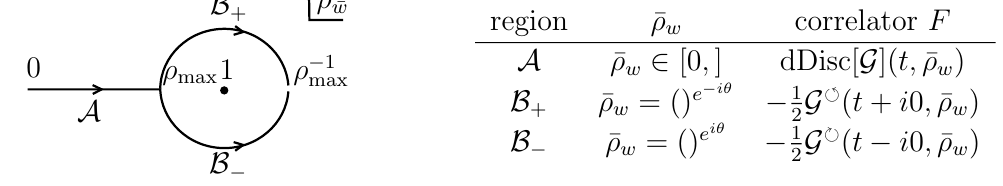
Figure 5 . Keyhole contour in the (cid:22) (cid:26) w variable to avoid cross-channel singularity (at (cid:22) w = 1). The angle runs over (cid:18) 2 [0 ; (cid:25) ]. The radius of the circle shrinks as (cid:26) max ! 1.